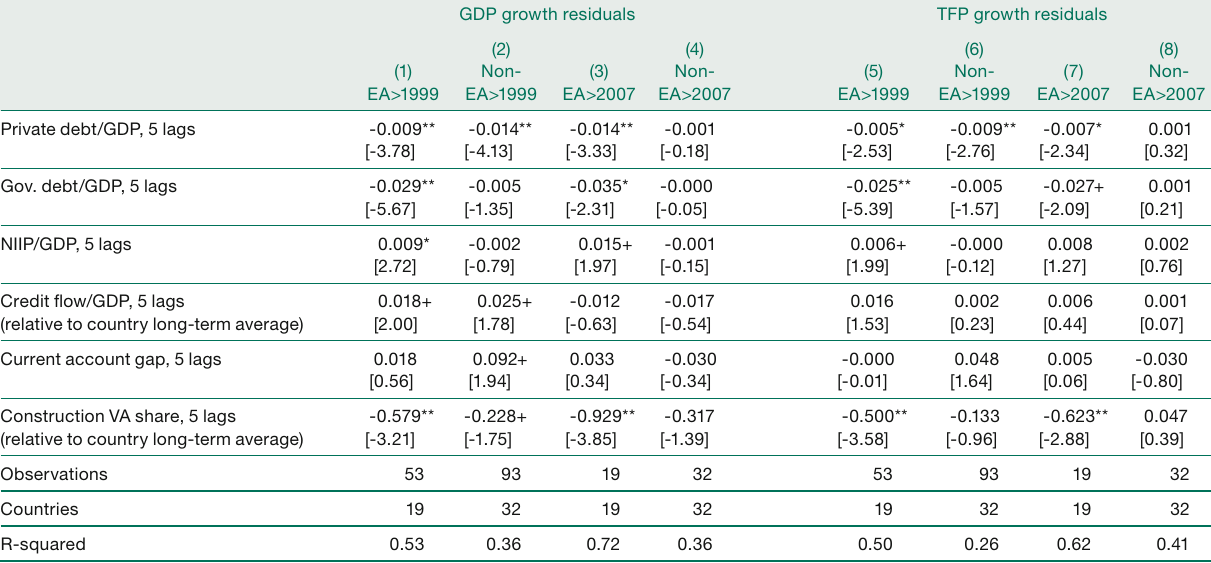
Deviations from convergence paths and macroeconomic imbalances